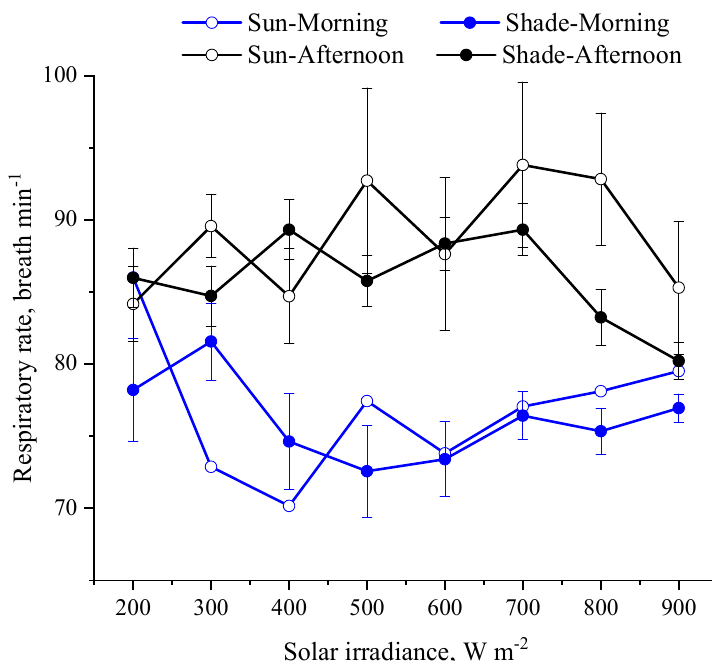
Figure 6. Least square means ( ± SEM) of respiratory rates of heifers in when they are in shade and when exposed to sun.